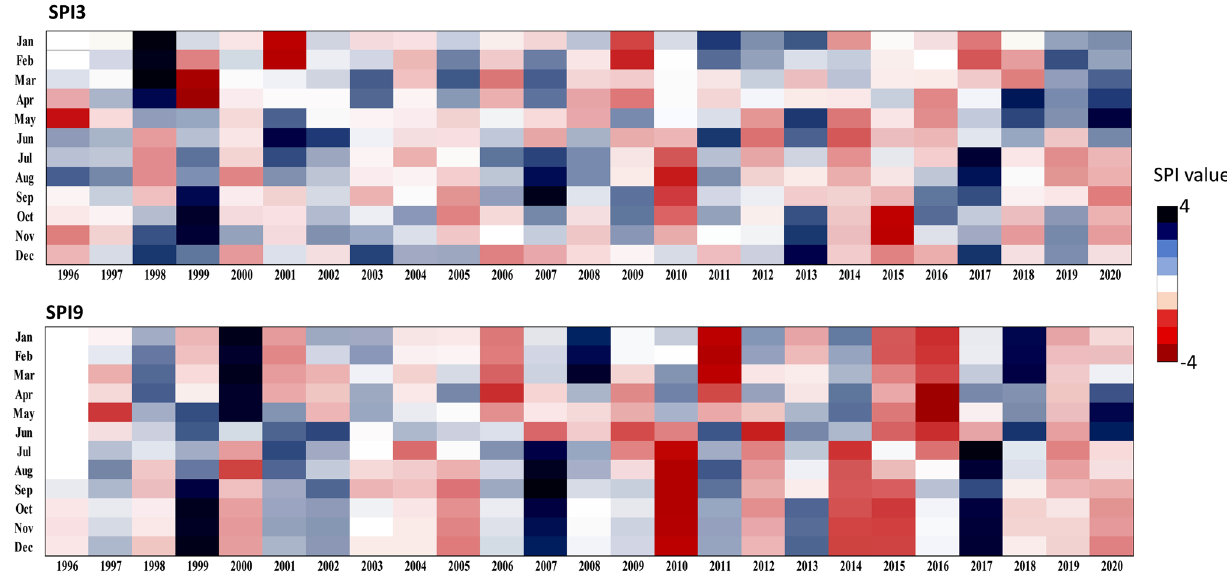
Fig. 8 Drought heat map of SPI3 & SPI9 showing the drought periods within the restricted time